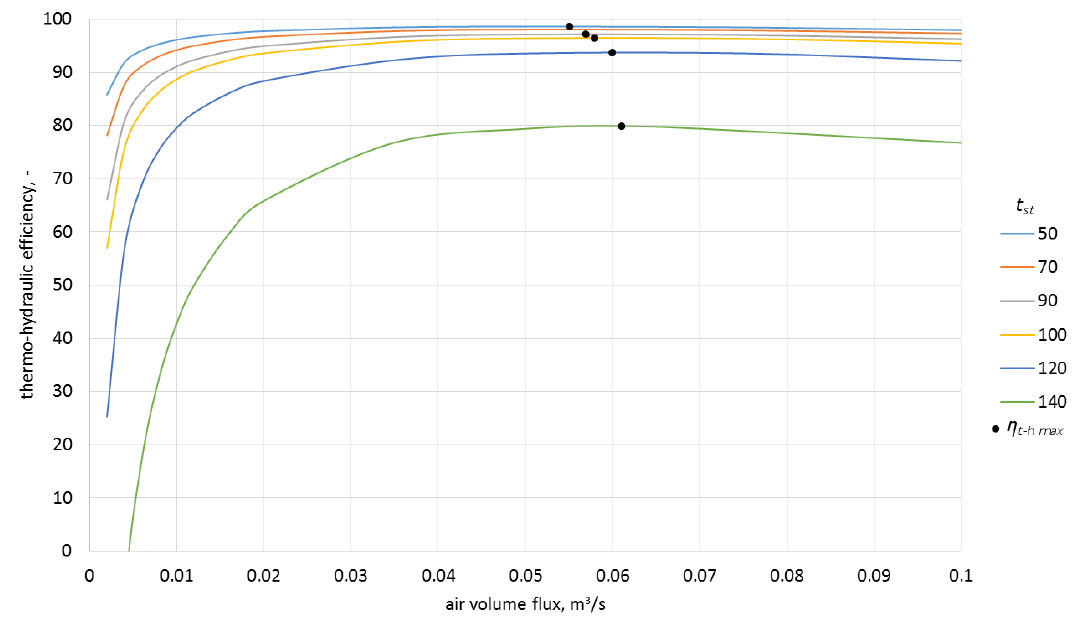
Figure 13. Thermo-hydraulic efficiency for the inlet temperature of 200 °C and various ceramic brick temperatures.